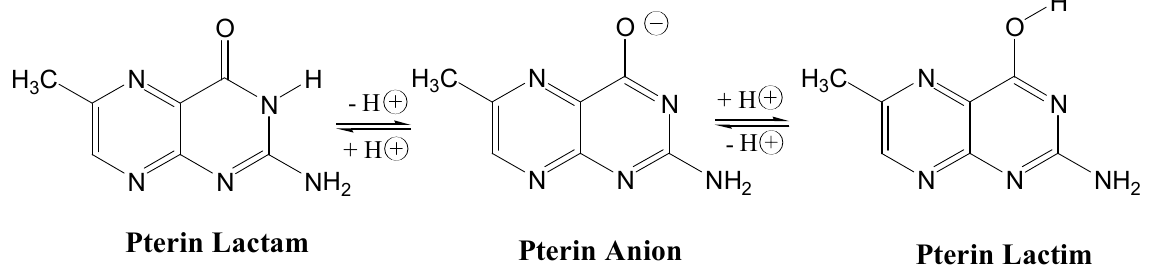
Figure 1. Commonly accepted structures of the lactam, lactam, and anionic pterin